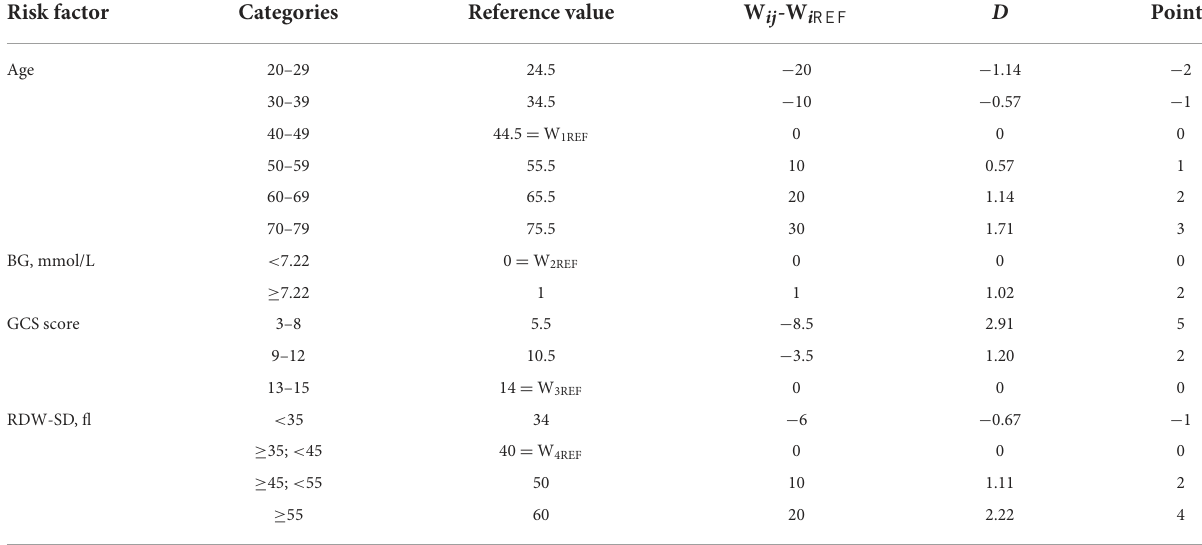
TABLE 3 Predictive model using risk factor categories.